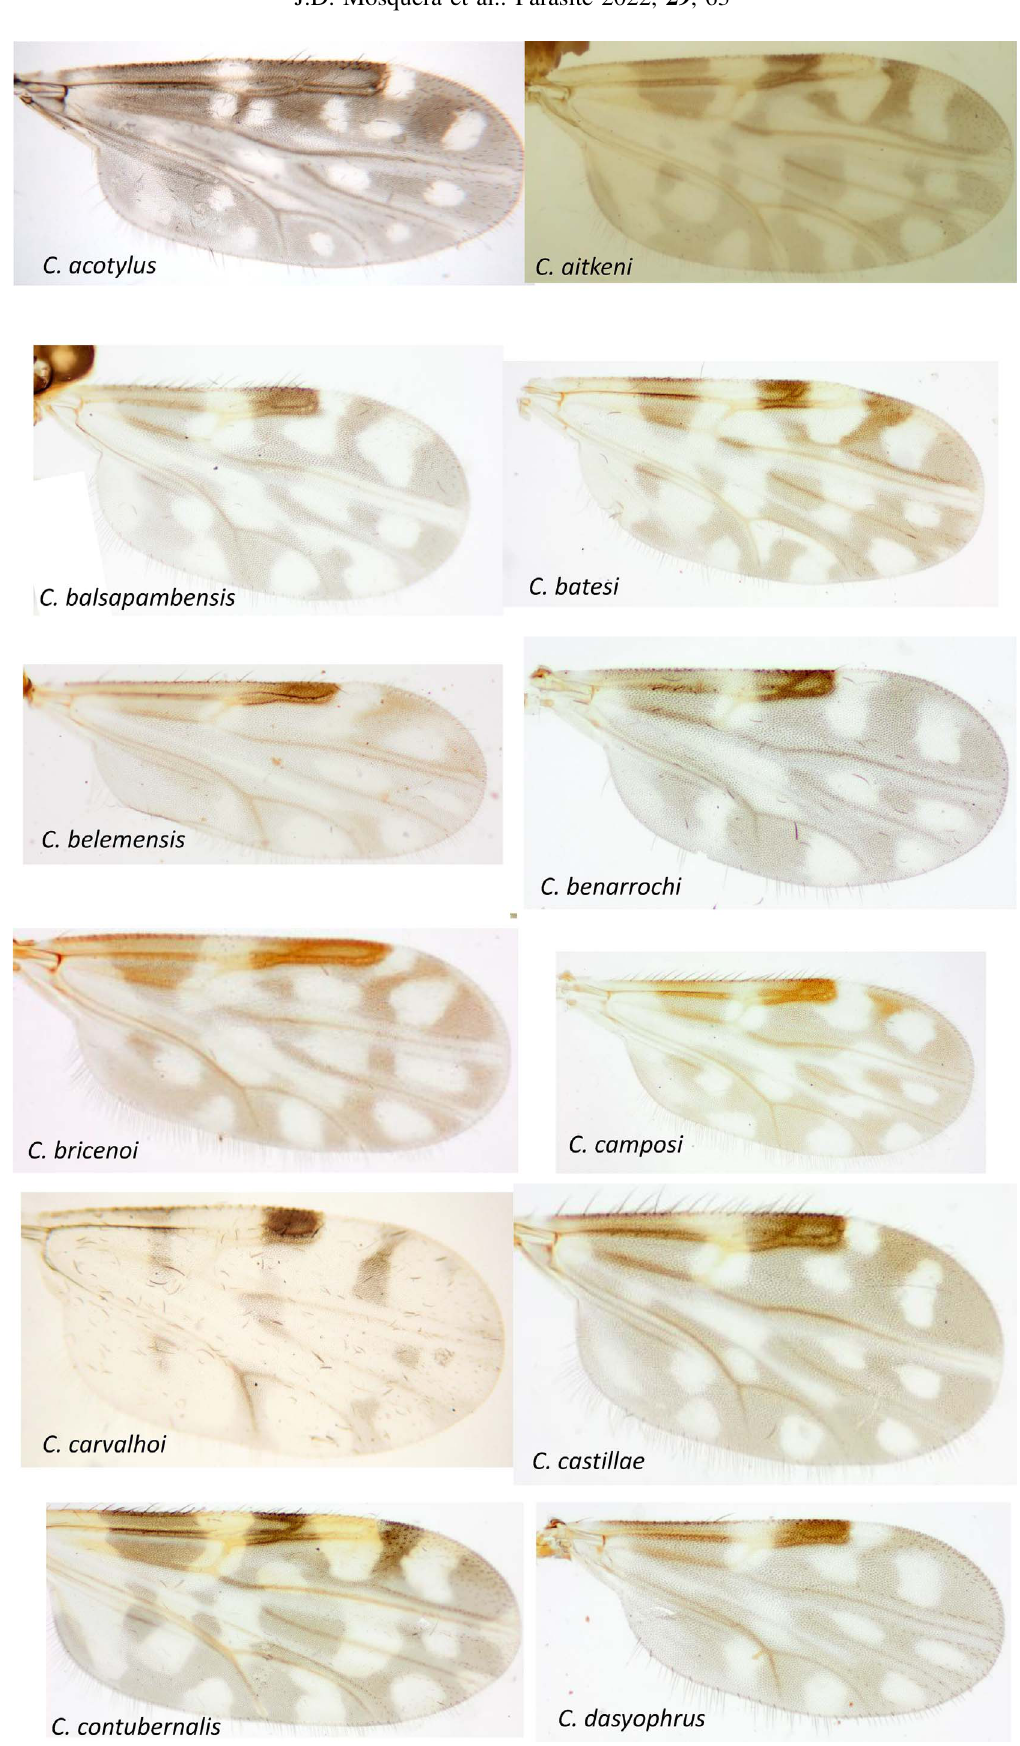
Figure 2. Wing photographs of Culicoides species in Ecuador. The new Culicoides records are: C. acotylus , C. aitkeni , C. benarrochi , C. carvalhoi , C. freitasi , C. ginesi , C. lopesi , C. lyrinotatus , C. profundus , C. pseudoreticulatus , C. quasiparaensis , C. vernoni , C. youngi and two new species ( Culicoides n. sp. 1 and Culicoides n. sp.